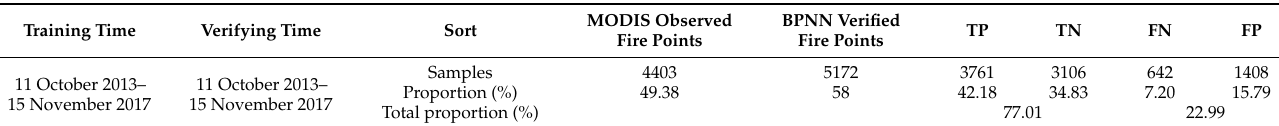
Table 3. The results of BPNN ensembles in forecasting fire points over Northeastern China in 2013–2017 using the optimized model for Scenario